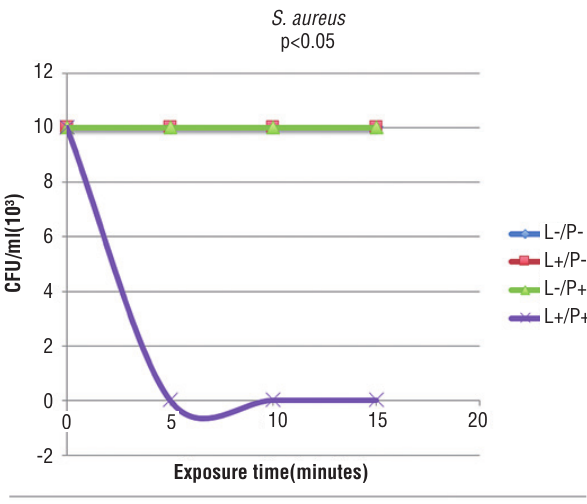
Figure 1 - Mean CFu/mL of s. aureus submitted to the following treatments: saline as control (L-/P-), laser and saline (L+/P-), photosensitizer (L-/P+), and laser and photosensitizer (L+/P+) (Tukey test, p<0.05).